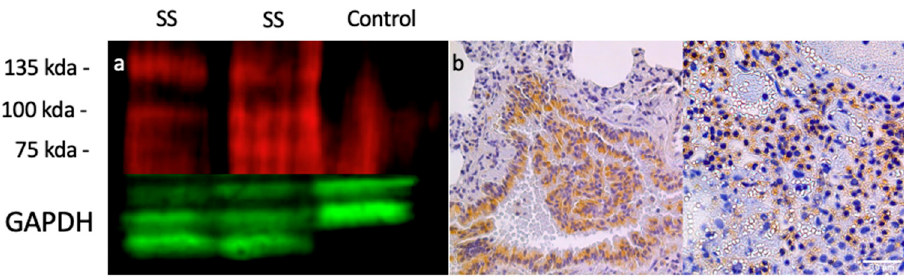
Figure 2. Protein expression of OSMR. ( a ) Western blot using immunofluorescent tags. OSMR is in red and control GAPDH is in green. Three bands were detected corresponding to the OSMR receptor (135 kDa), IL-31 receptor (100 kDa), and the OSMR subunit alone (75 kDa). Samples 1 and 2 are metastatic tumor samples, sample 3 is normal muscle tissue. ( b ) Immunohistochemistry staining of lung metastasis (left) and primary tumor (right). OSMR expression appears brown in tissue samples.